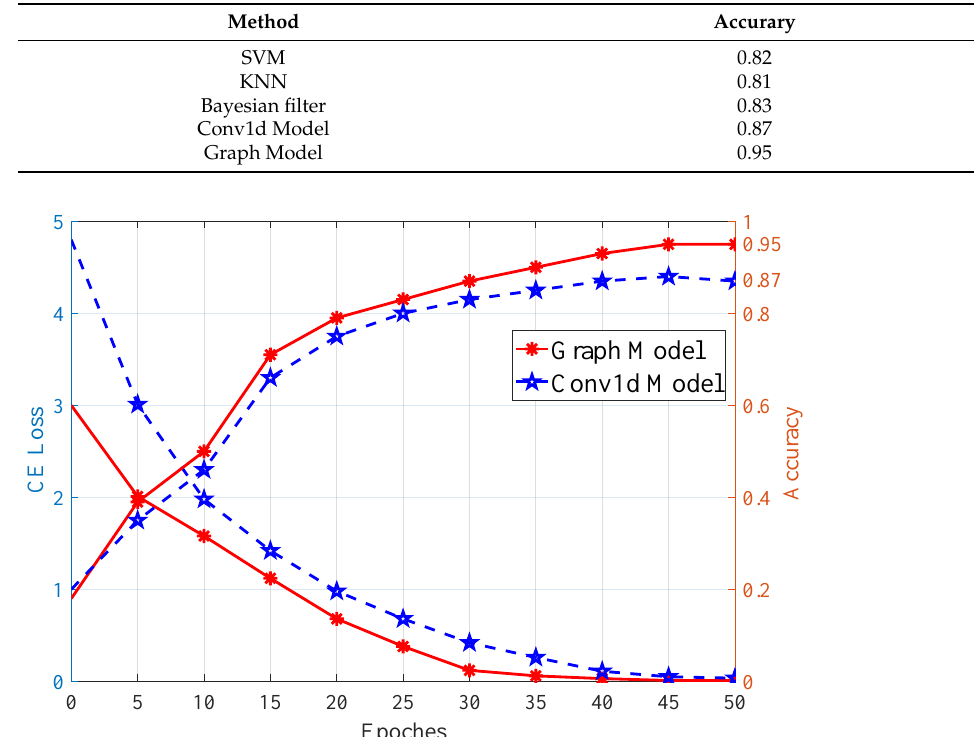
Table 3. Resultant recognition accuracy of different methods.